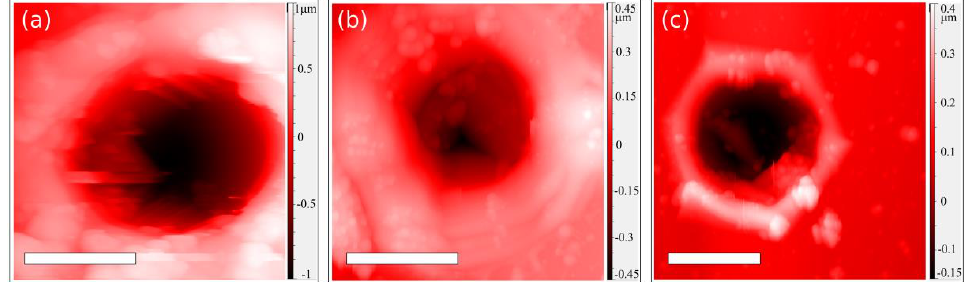
Figure 6. Surface topography of a single crater inscribed at E = 37.5 nJ and numbers of pulses: 8 ( a ), 3 ( b ), and 1 ( c ). Scale bar −1 µm . The profiles along the center of a single crater inscribed at Е = 37.5 nJ and pulse numbers 8, 3, 1 were obtained from 2D surface topography and presented in Figure 7 . The depth of the crater increased from 0.3 µm at the impact of one pulse to 0.7 µm at impact of 3 pulses and to 1.7 µm at impact of 8 pulses. Moreover, in the case of single pulse im- pact, the height of the crater rim was measured, and it equaled to ≈100 nm. Thus , the in- crease in the number of pulses used for the creation of a single crater led to an increase in the depth of the crater, resulting in more effective antireflective spectral properties of ARM in this case. Figure 7. Surface profiles of a single crater inscribed at Е = 37.5 nJ and numbers of pulses: 8 ( a ), 3 ( b ), and 1 ( c ). 3.2. Transmission Spectra The measured transmission in the mid-IR spectral range of a freshly cleaved GaSe sample was around 65% and could be increased by an inscription of ARM. For this pur- pose, various ARM structures were inscribed on the GaSe sample at different pulses of energy (Е = 5.8 nJ, 8.4 nJ, 15.8 nJ, and 23.4 nJ) and numbers of laser pulses used for the creation of a single crater (N = 1, 3, 5, 8). The obtained transmission spectra of ARMs are presented in Figure 8 in comparison with the initial transmission spectrum of a GaSe monocrystal (black line on the Figure 8).